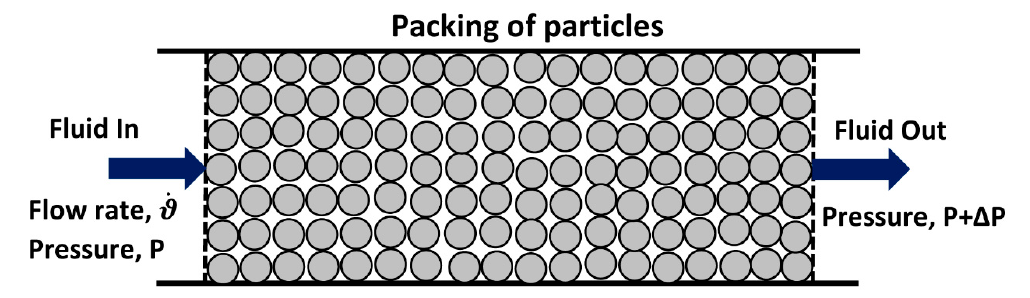
Figure 6. Flow through a packed bed